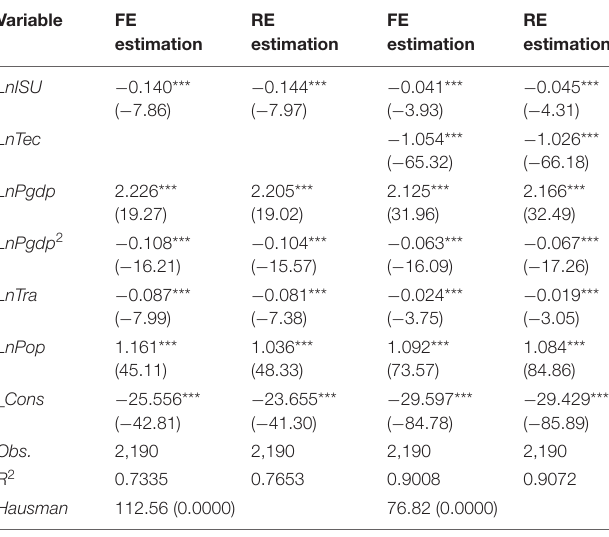
*** indicates statistical significance at the 1% level; the values in parentheses represent